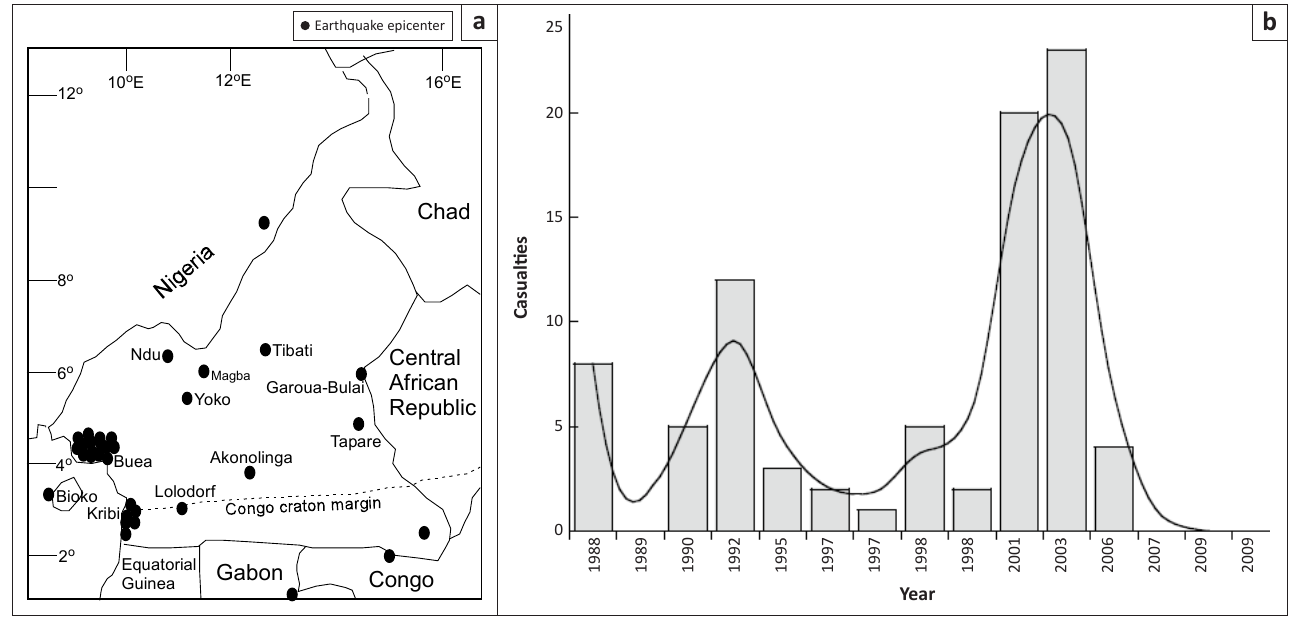
FIGURE 4: (a) Felt earthquakes in Cameroon over the past 160 years (from 1852 until today). Note the concentration of earthquakes around Buea and Kribi. (b) Landslide casualties in Cameroon for the past 20 years